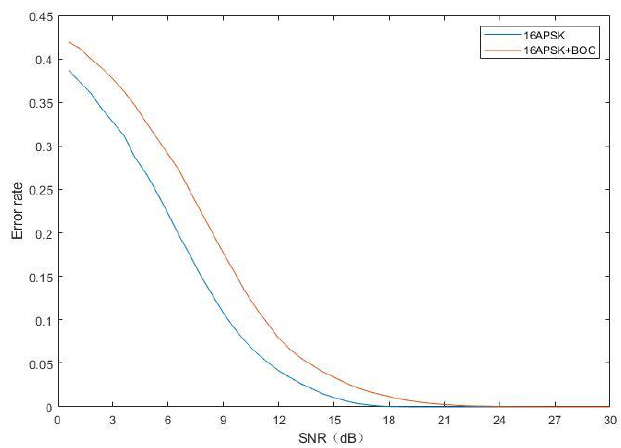
Figure 8. The data transmission error rate of an integrated signal and pure signal.